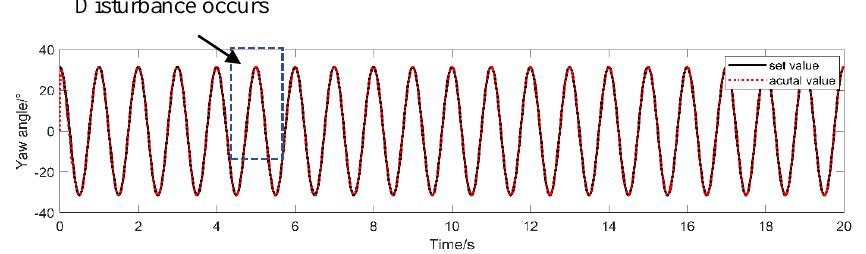
Figure 14. Y a w tracking of the standard sliding mode controller.